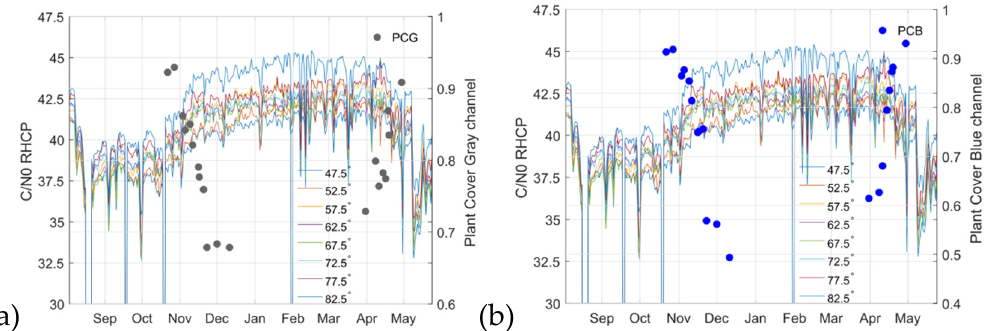
Figure 10. ( a ) Evolution of the percentage of sky covered and C / N 0 curves as a function of time: Figure 10. ( a) Evolution of the percentage of sky covered and C/N 0 curves as a function of time: a) ( a ) using a gray-scale image; and ( b ) using the blue channel of the RGB using a gray-scale image, and (b) using the blue channel of the RGB image.